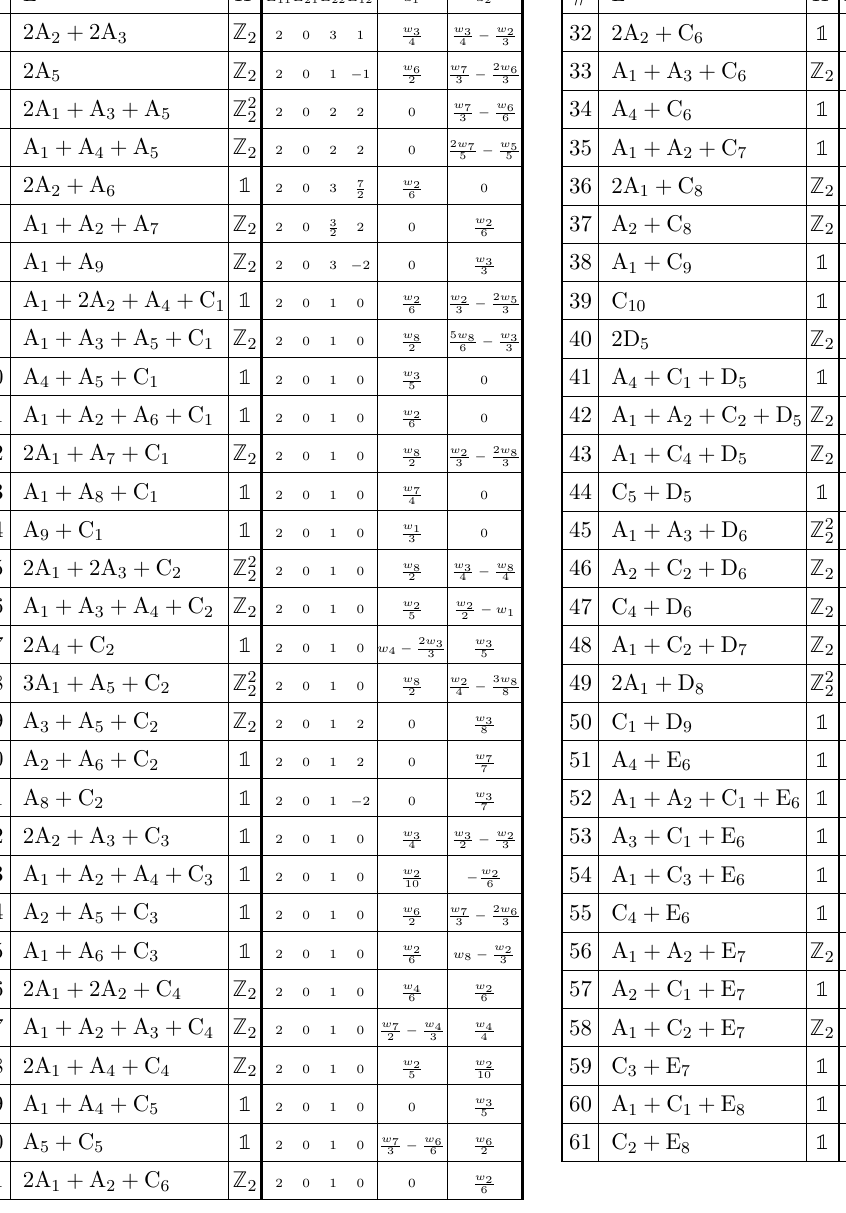
Table 7 . All groups of maximal enhancement in the 8-dimensional CHL string. The Wilson lines are given in terms of the fundamental weights of E 8 , see table 2. ADE groups arise at level 2 and C groups at level 1